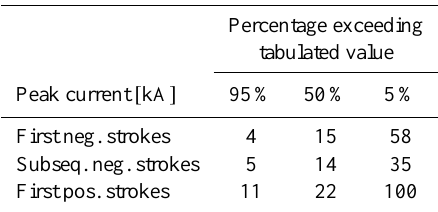
Table 1. Peak current cumulative statistical distribution